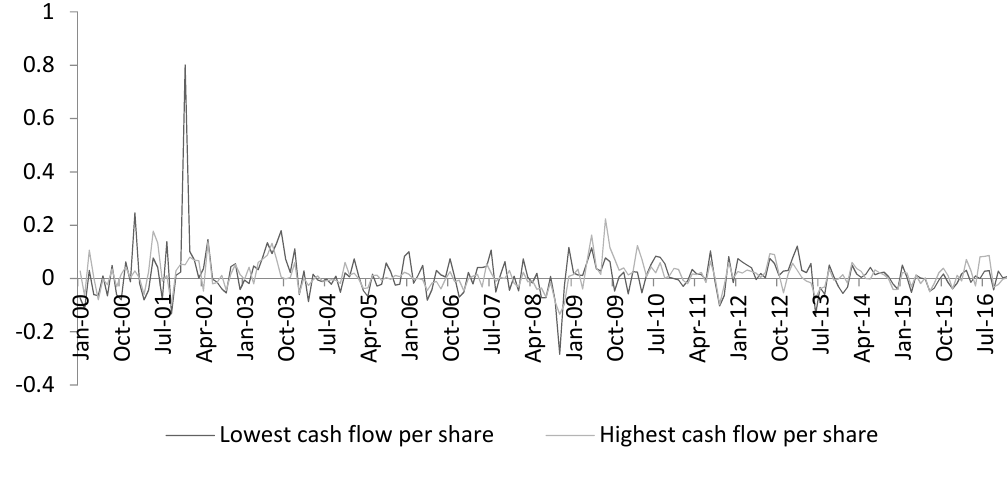
Figure 3. Cash flow per share indexes. Table 6. Correlation between CF per share based index.